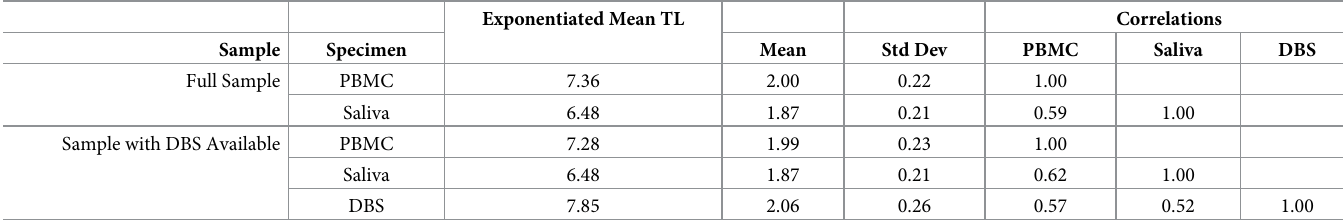
Table 4. Mean, standard deviations, and correlations of ln(TL) by specimen type.